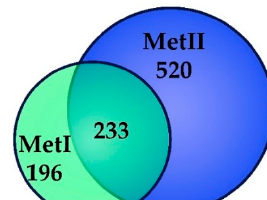
Figure 2. Proteomic identification of lipid raft enriched fractions of RBL-2H3 mast cells. MC lipid-raft-enriched Fractions 2 and 3 were used for Nano-UPLC-MS E analysis. A Venn diagram depicting the number of overlapping and unique proteins present in MC lipid rafts processed using Method I (MetI) and Method II (MetII) is shown.